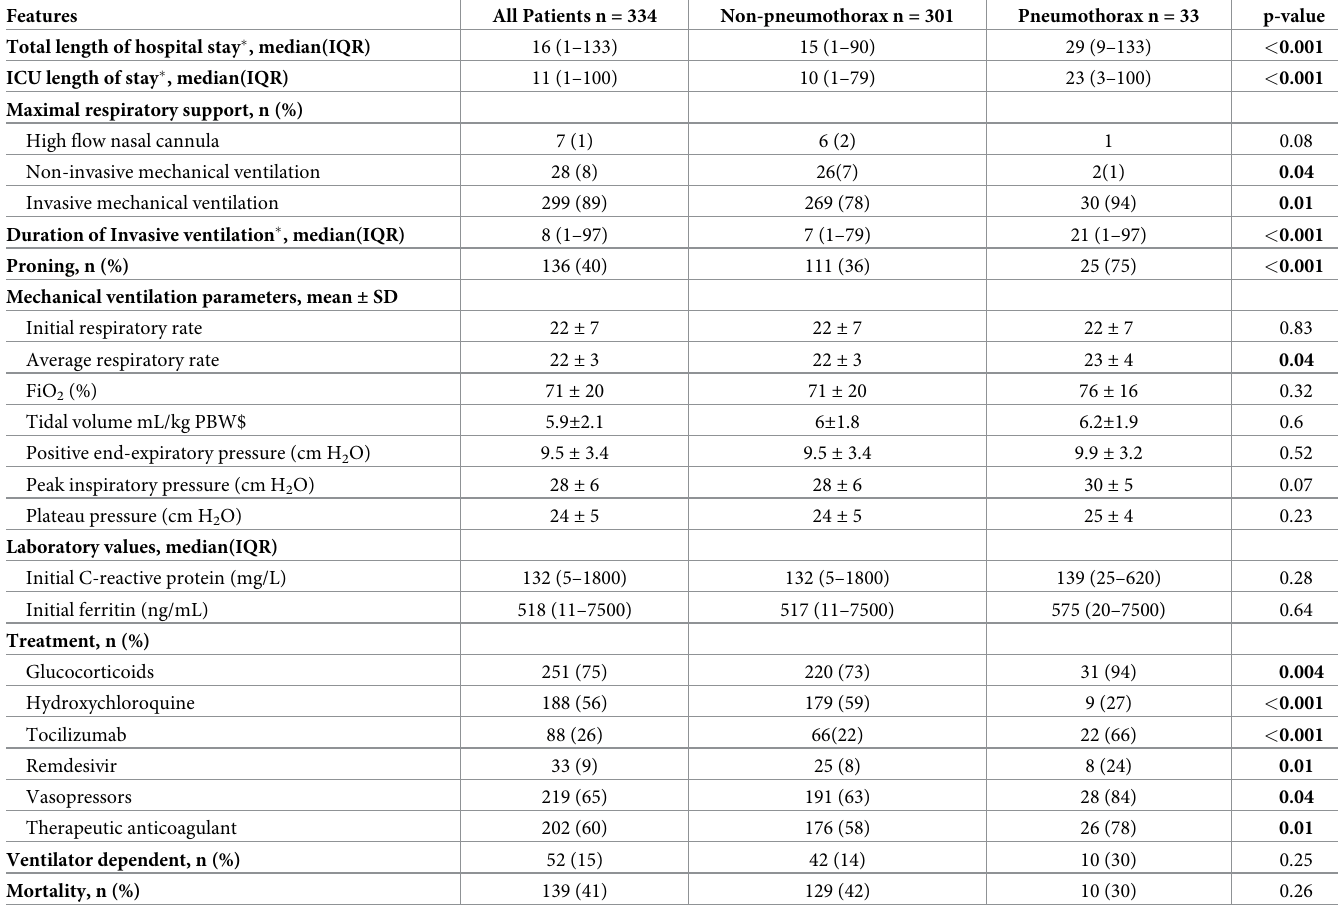
Table 2. Respiratory supports, medical managements and